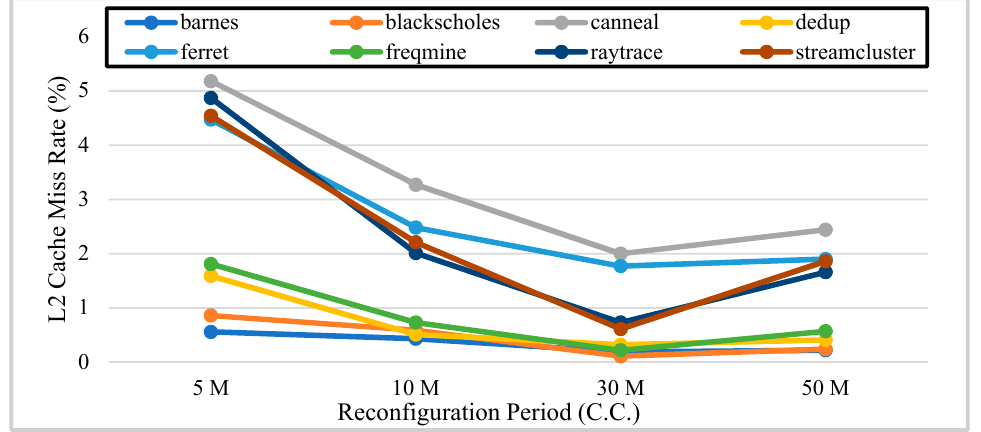
Figure 13. L2 cache miss rate of different reconfigurable periods.